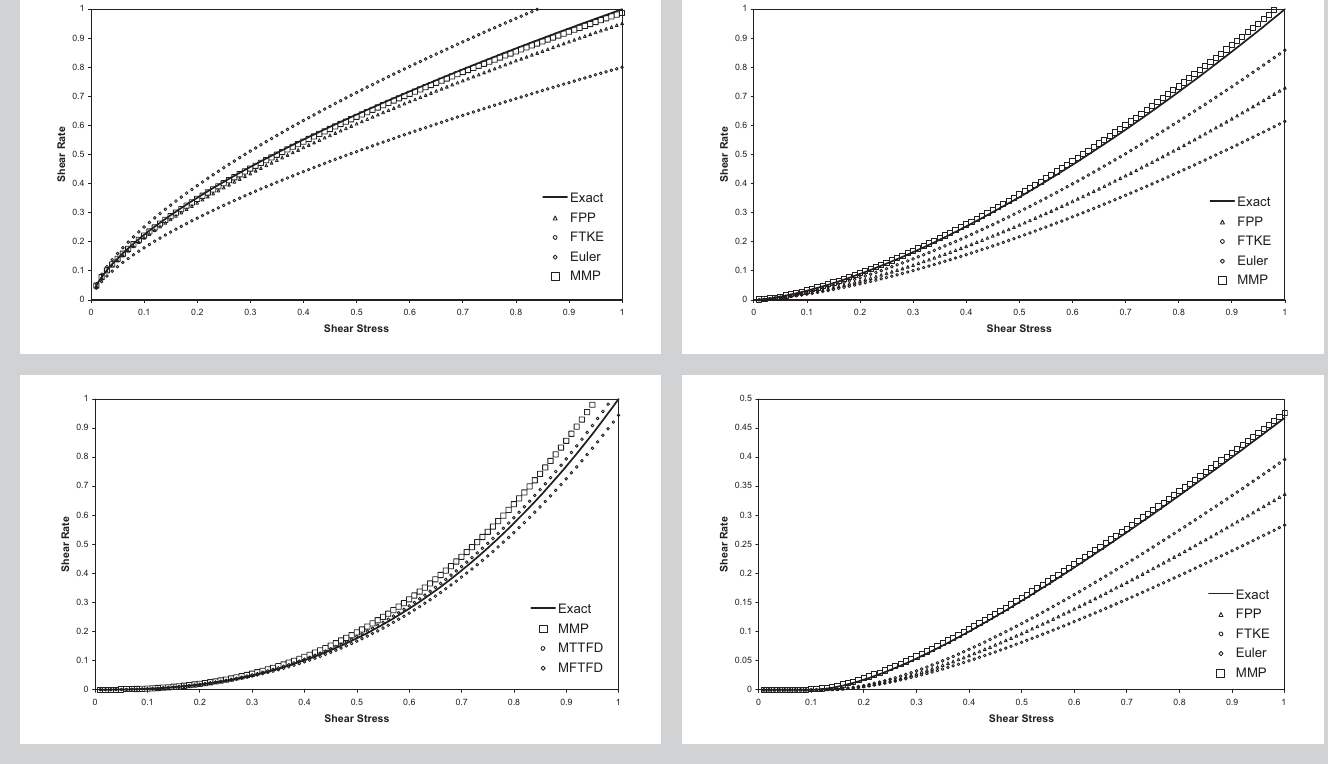
Figure 2 (left above): The recovery, from exact angular velocity data for a Couette rheometer with s = 0.7, of the flow curve (shear rate as a function of shear stress) for a Power Law fluid with exponent 0.65 by the FPP, FTKE, Euler and MMP approximations. Figure 3 (right above): The recovery, from exact angular velocity data for a Couette rheometer with s = 0.7, of the flow curve (shear rate as a function of shear stress) for a Power Law fluid with exponent 1.5 by the FPP, FTKE, Euler and MMP approximations. Figure 4 (left below): The recovery, from exact angular velocity data for a Couette rheometer with s = 0.75, of the flow curve (shear rate as a function of shear stress) for a Power Law fluid with exponent 2.5 by the MMP, MTTFD and MFTFD approximations. Figure 5 (right below): The recovery of the flow curve (shear rate as a func- tion of shear stress) for a Casson fluid by the FPP, FTKE, Euler and MMP appro- ximations from exact angu- lar velocity data for a Cou- ette rheometer with s =